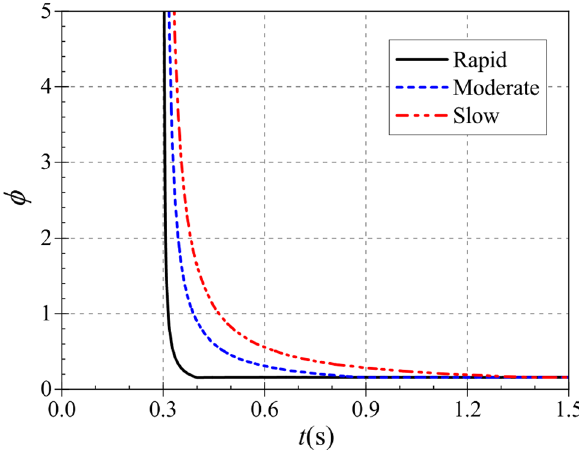
Figure 16. Dimensionless flow